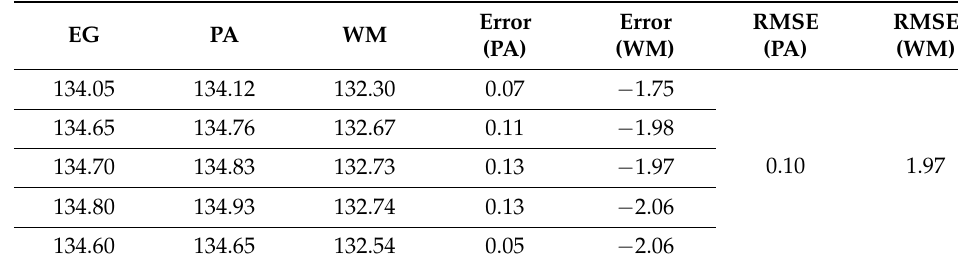
Figure 6. Measured angle using proposed algorithm (PA) and WitMotion (WM) (first trial).